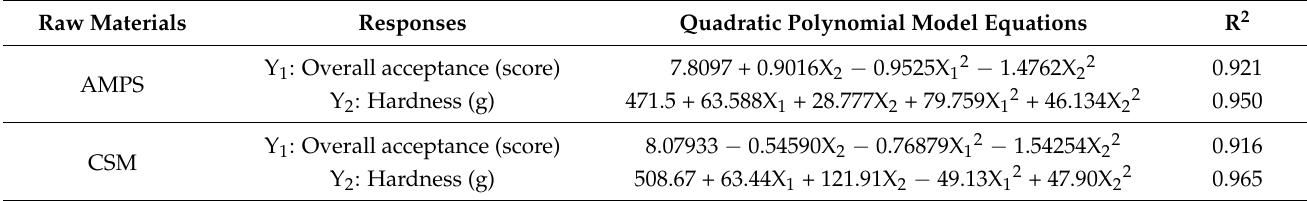
Table 3. Response surface model equations of AMPS and CSM.